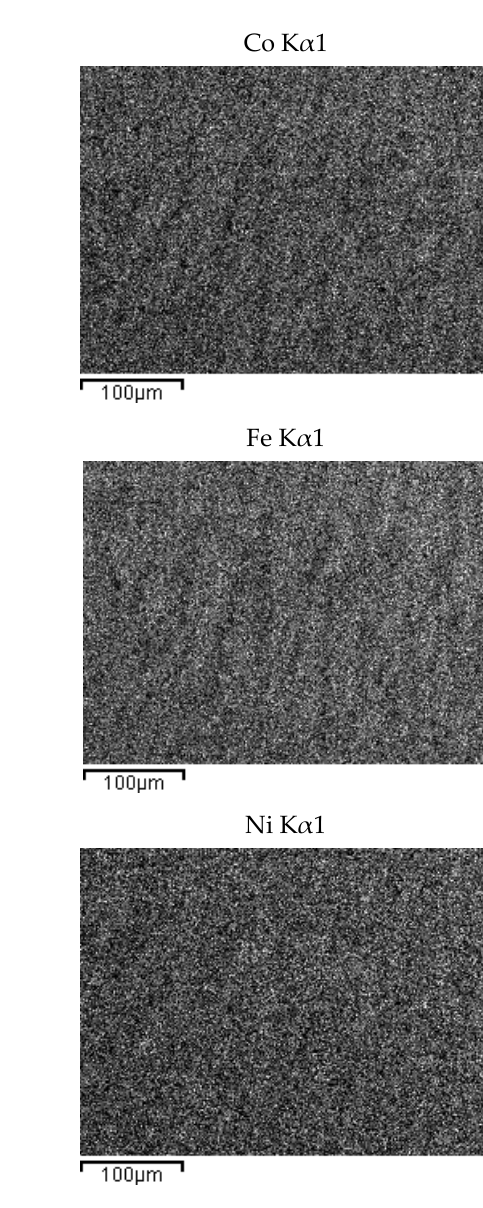
Figure 3. EDS mapping of as-cast Co 19 Cr 19 Ni 19 Fe 19 Mn 19 Zr 5 . The maps report, from left to right and top to bottom, the elec- tron image of a portion of the specimen and the corresponding elemental distribution of Cr, Fe, Co, Ni, Zr, Mn.